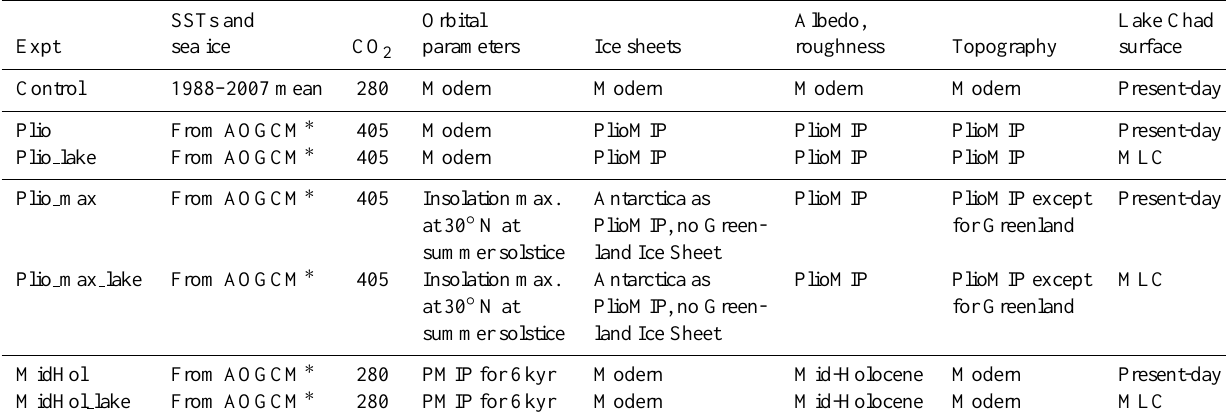
Table 1. Boundary conditions for the